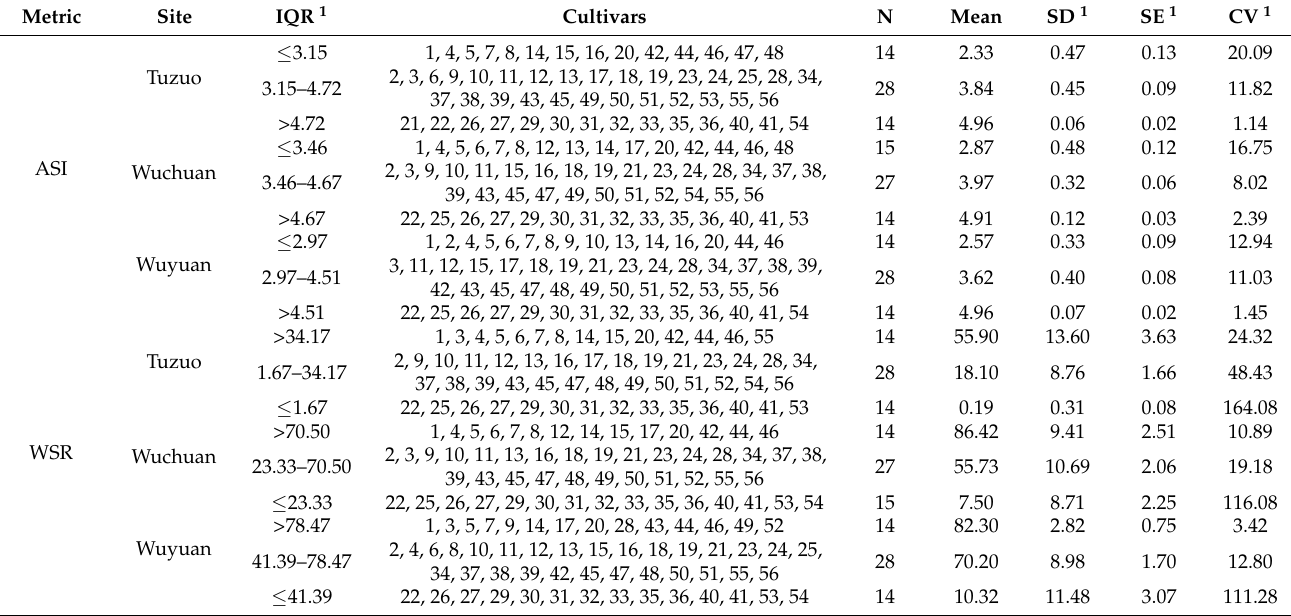
Table 5. Quartile ranges and summary statistics of winter hardiness measurements in 56 alfalfa cultivars. Metric